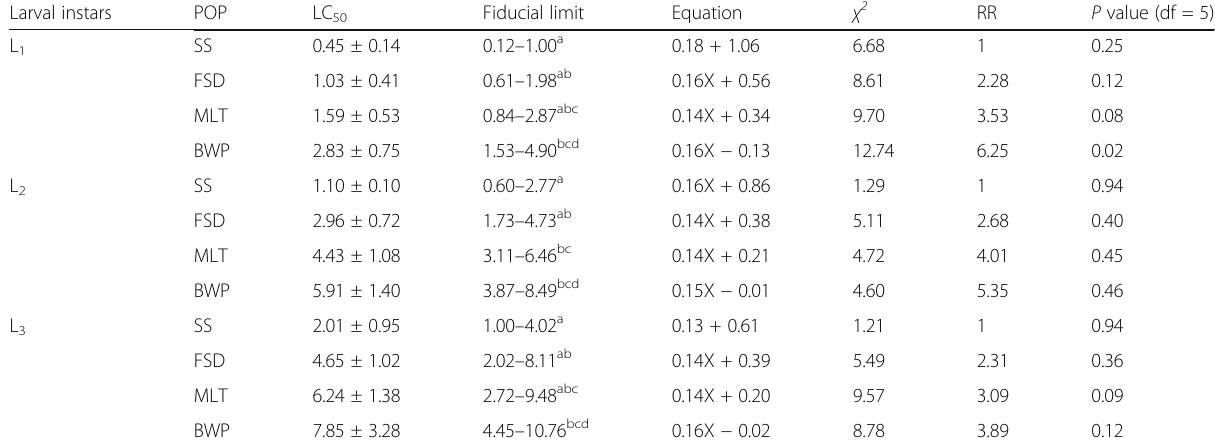
Table 3 Lethal concentration of susceptible and field population of Spodoptera exigua to Cry1Ac toxin during 2016 Larval instars